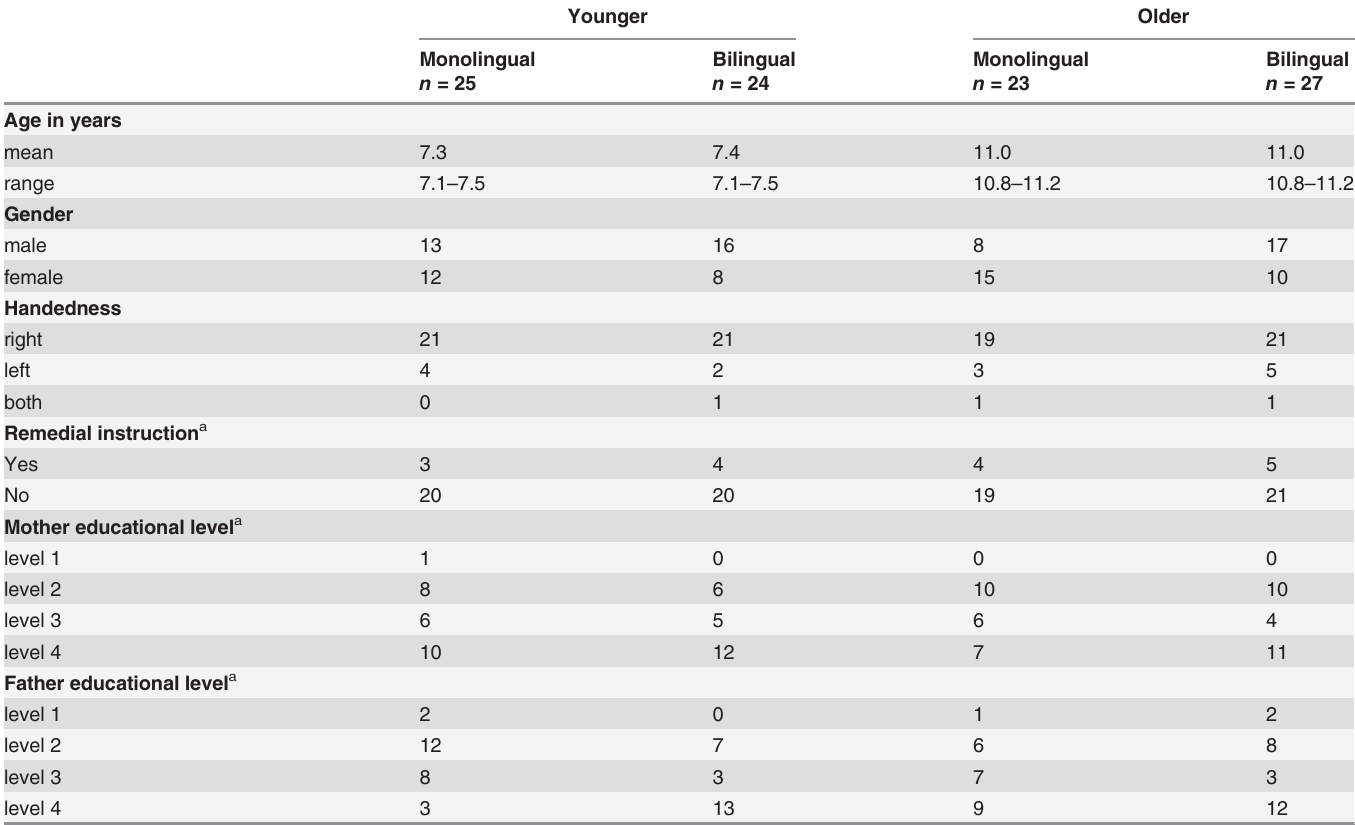
Table 2. Background data on the